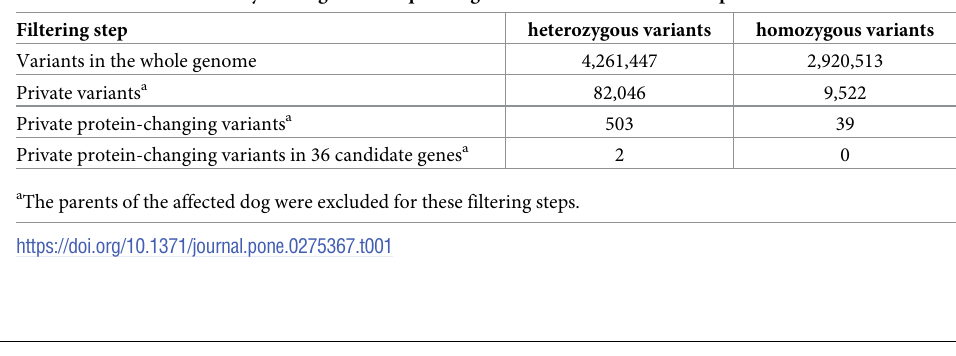
Table 1. Variants detected by whole genome sequencing of the affected Chinese